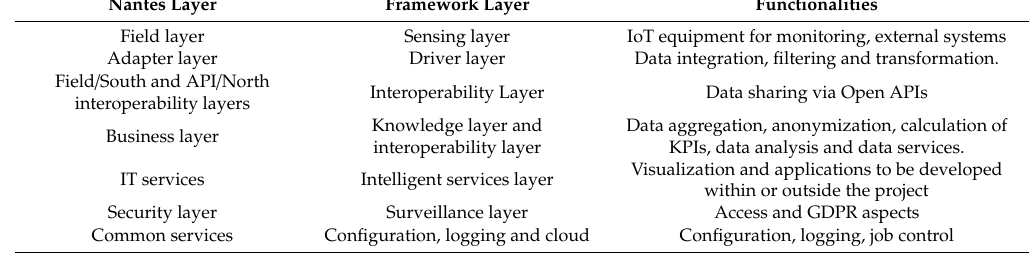
Table 1. Mapping the Open Specifications Framework and Nantes Urban Platform.